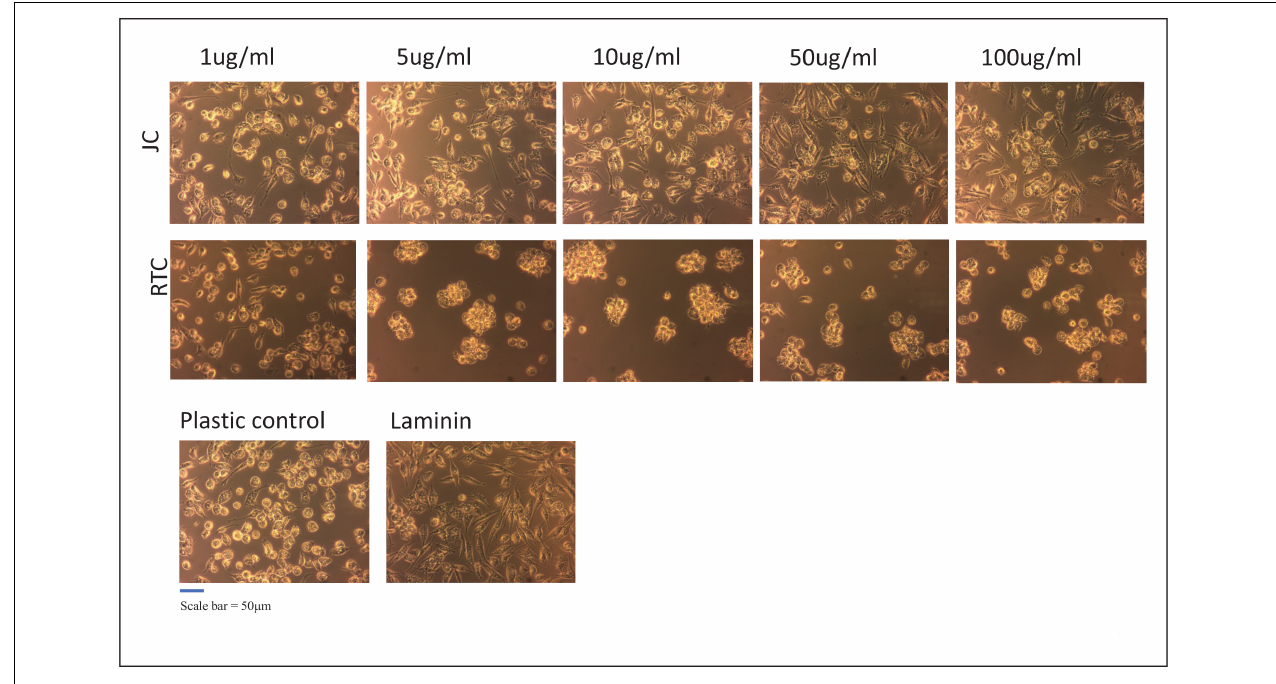
FIGURE 1 | iMGL were cultured on different coating concentrations of Jellagen R (cid:13) . jellyfish collagen (JC), rat tail collagen I (RTC) (1–100 µ g/mL), Laminin or Plastic Control (TC plastic) for up to 72 h and morphology observed by phase-contrast imaging at 72 h culture. Scale bar = 50 µ m. Images taken at x10 magnification.